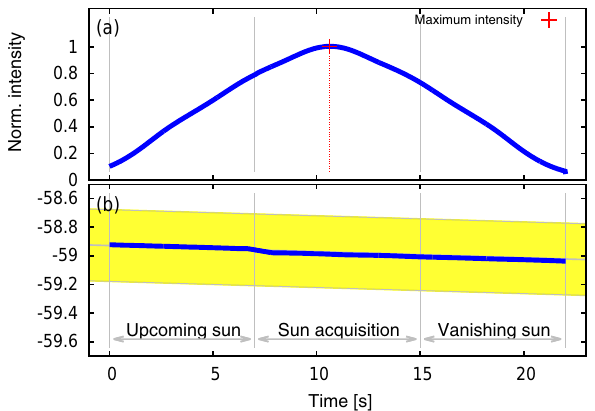
Figure 2. Schematic sketch of SCIAMACHY’s scanner unit. The yellow beam follows the limb light path.